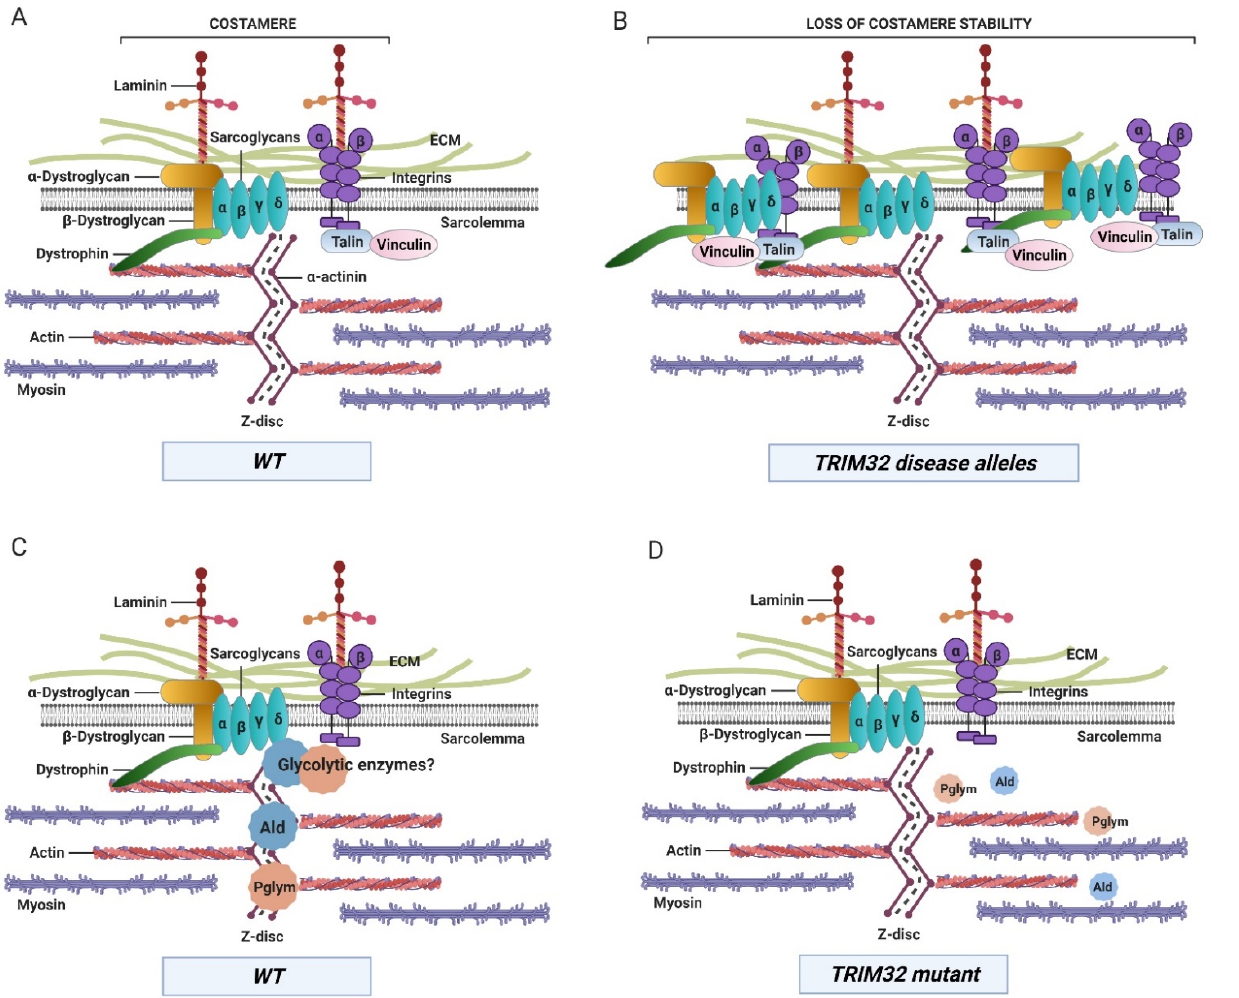
Figure 5. Compromising TRIM32 function results in the abnormal accumulation of costamere components and a decrease in glycolytic enzyme protein levels and/or localization within muscle tissue. ( A ) Large protein complexes called costameres connect the contractile apparatus at the Z-disc and sarcolemma to the extracellular matrix (ECM). ( B ) Both dystrophin glycoprotein complex (DGC) and integrin complexes are present at higher levels and lose their costamere location upon loss of TRIM32 or upon expression of LGMD2H alleles. ( C ) The glycolytic enzymes Ald and Pglym are found at the Z-disc in close association with costameres in normal muscle tissue. ( D ) Loss of TRIM32 reduces the levels of these proteins, either due to loss of their normal localization or lack of protein stability. WT, wild type.